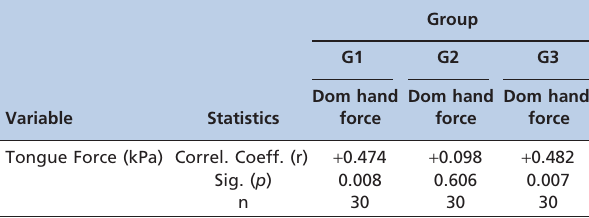
Table 5 - Analyses of tongue force and dominant-hand grip strength in the three